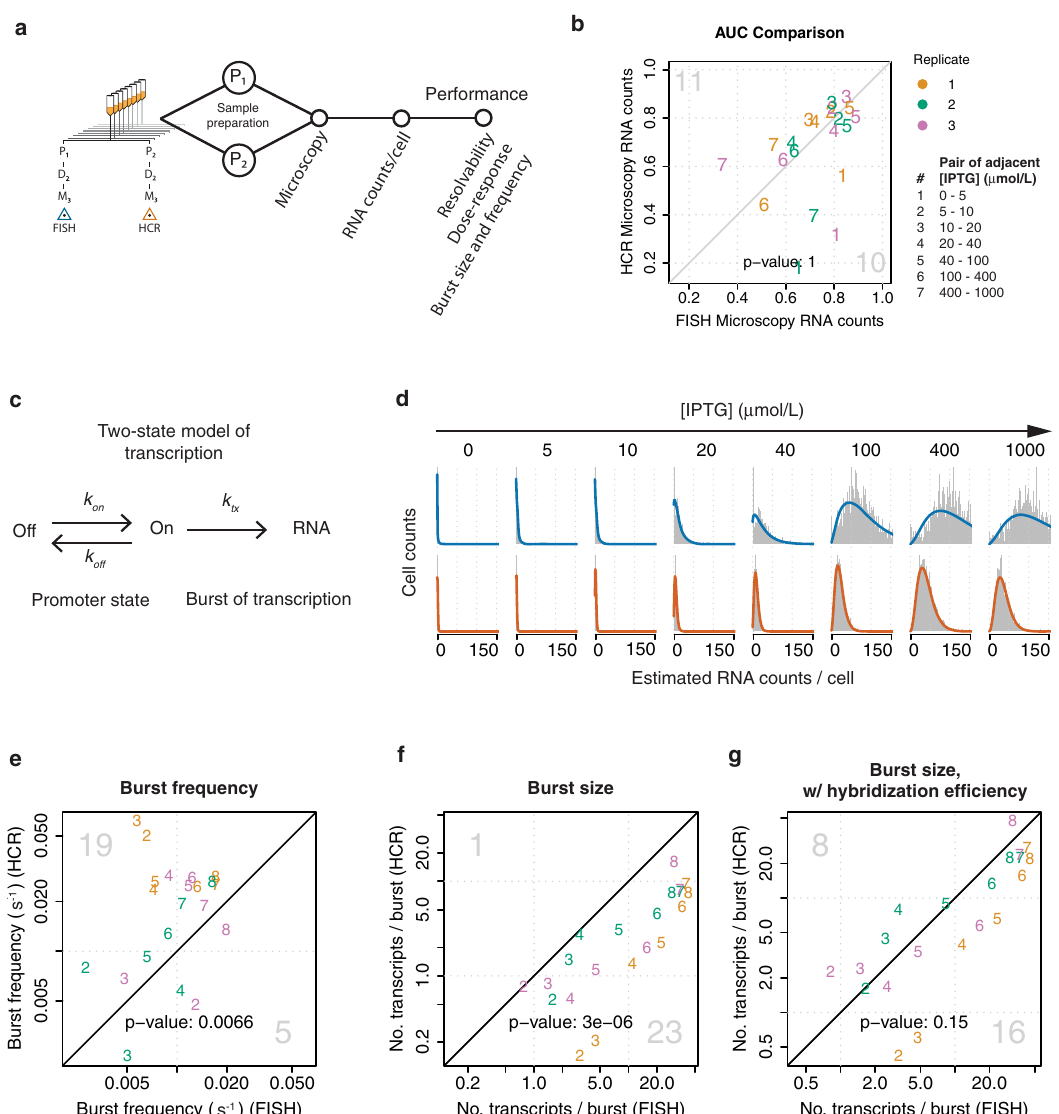
Fig. 6 Performance of single-transcript methods can be attributed to RNA labeling strategy. a Performance of single-transcript methods was compared using cells that shared the same steps of the measurement process except for the RNA labeling step. b Resolvability of FISH and HCR was assessed by plotting AUC calculated from adjacent stimulus levels. Pairs of adjacent IPTG concentrations are shown as numbers within the plots, as indicated in fi gure legend. c A two-state promoter model was used to evaluate transcription kinetics. d Negative binomials were used to fi t single-transcript distributions for FISH (blue) and HCR (dark orange). e Estimates of burst frequency are plotted for FISH versus HCR. The RNA lifetime was assumed to be a constant (2.8 min). f Estimates of burst size, and g estimates of burst size after correcting for hybridization ef fi ciency, are plotted for FISH versus HCR. For parts ( f ) and ( g ), burst size is the number of transcripts per burst. For parts ( e ), ( f ), and ( g ), the scatter plot numbers 2, 3, 4, 5, 6, 7, and 8 represent 5, 10, 20, 40, 100, 400, and 1000 μ mol/L IPTG, respectively. The 0 μ mol/L IPTG case is not shown, in order to more easily see the trend for the remaining induction conditions. For ( b ), ( e ), ( f ), and ( g ): Diagonal line indicates equivalent performance between the two methods. Color indicates biological replicates one (orange), two (green), and three (purple), as indicated in the fi gure legend. Large gray numbers in the top-left and bottom right-corners indicate how many values were higher for the method plotted on the y -axis or x -axis, respectively. The two-sided p -values for a sign test are shown within each